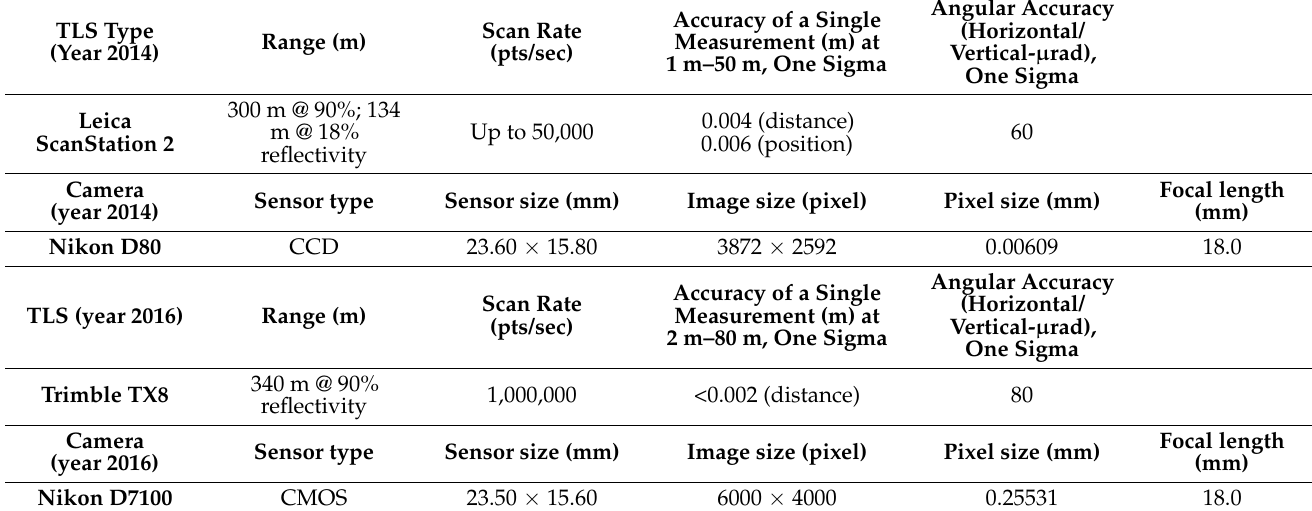
Table 1. Utilised terrestrial laser scanners and cameras